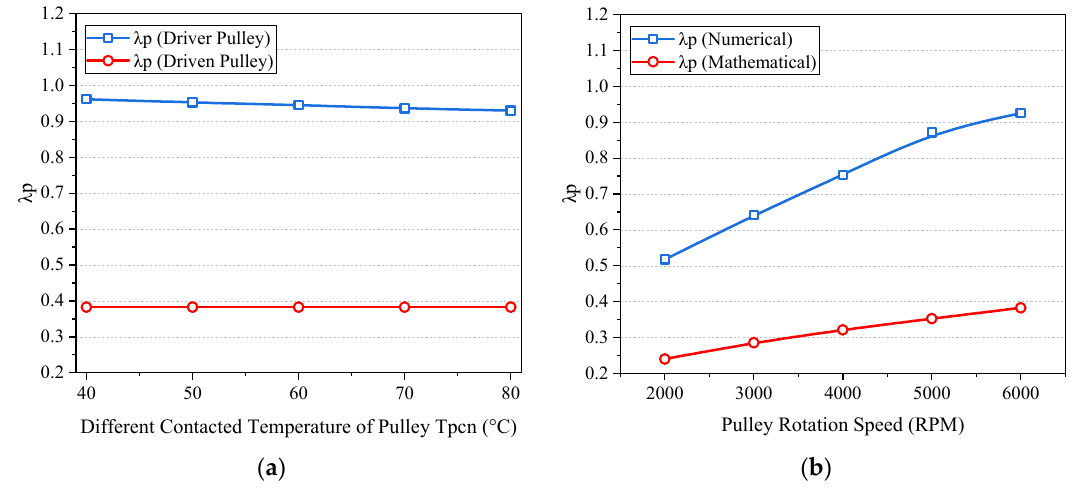
Figure 11. Comparison of numerical and mathematical results on λ pn for a pulley with a radius of 76.2 mm under ( a ) various contacted temperatures of pulley T pcn at the speed of 6000 RPM ( b ) various rotational speeds ranging from 2000–6000 RPM at the T pcn = 60 ◦